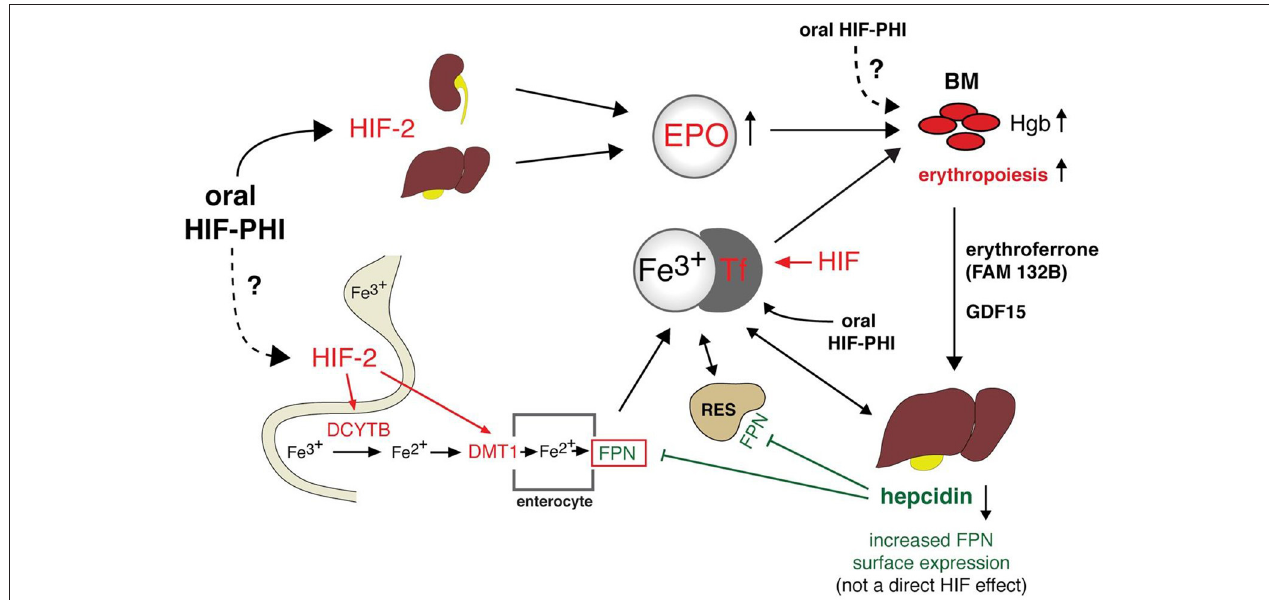
FIGURE 2 | Integrated model for CKD-anemia physiology and actual and potential treatments. HIF, hypoxia-inducible factor; Fe, iron; HIF-PHI, hypoxia inducible factor prolyl hydroxylase inhibitor; EPO, Erytrhopoietin; Tf, transferrin; DCYTB, duodenal cytochromeb; DMT1, divalent metal transporter 1; BM, Bone marrow; FPN, ferroportin; GDF15, Growth differentiation factor 15; Hgb, hemoglobin; RES, Reticuloendothelial system; FAM132B, Gene that codes for